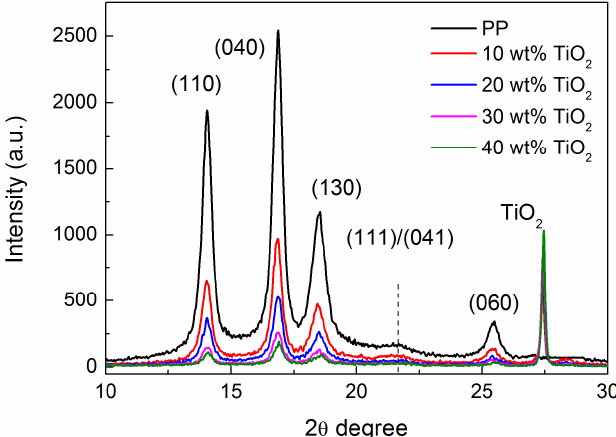
Figure 2. X-ray diffraction patterns for the PP and PP/TiO 2 composite films with different TiO 2 concentrations.